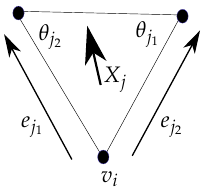
Figure 16. Computing the divergence at vertex v i